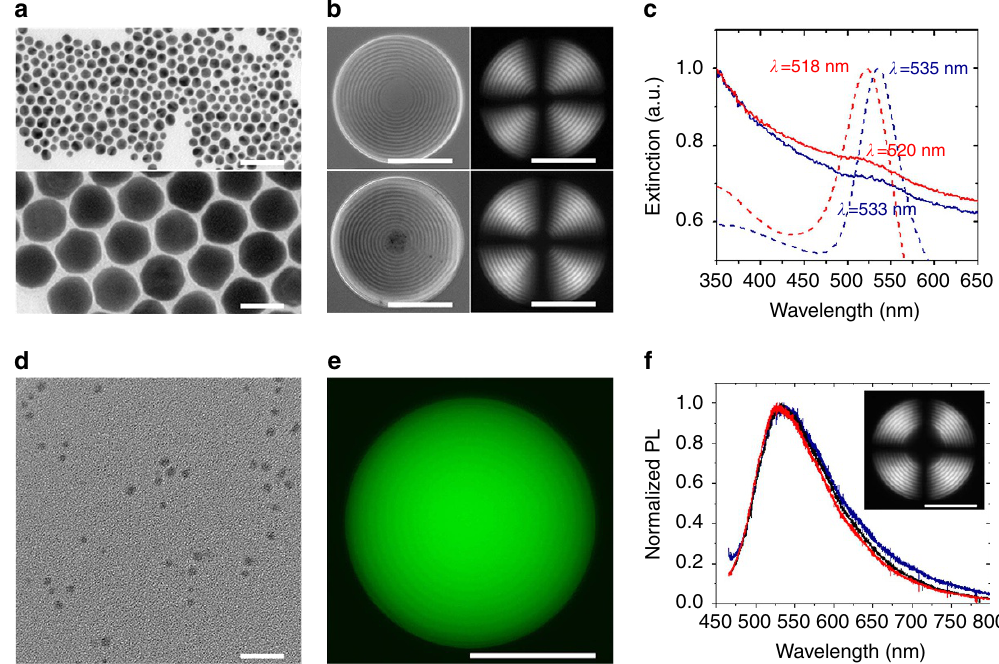
Figure 7 | Co-assembly of CNCs and inorganic nanoparticles. ( a ) TEM images of 10nm (top) and 50nm (bottom) gold NPs. The scale bar is 50nm. ( b ) BF (left panel) and POM (right panel) images of the Ch-CNC droplets loaded with 10nm gold NPs (top panel) and 50nm gold NPs (bottom panel). The concentration of gold NPs in the droplets is 0.1mgml (cid:2) 1 . The scale bar is 50 m m. ( c ) Extinction spectra of aqueous gold NP dispersion (dashed lines) and Ch-CNC droplets (solid lines) loaded with 10nm (red lines) and 50nm (blue lines) gold NPs. The broadening of extinction spectra of the NP-loaded droplets was caused by the light scattering by droplets in the visible light region. ( d ) TEM images of carbon dots. The scale bar is 20nm. ( e ) FM image of the Ch-CNC droplet carrying carbon dots at concentration of 1mgml (cid:2) 1 . The scale bar is 50 m m. ( f ) Photoluminescence spectra of the core (black line) and shell (red line) of the Ch-CNC droplets loaded with carbon dots, and an aqueous dispersion of carbon dots (blue line), both excited at l exc ¼ 440nm. Inset: POM image of the droplet loaded with carbon dots. The scale bar is 50 m m. f 0 ¼ 0.043 in b – f .